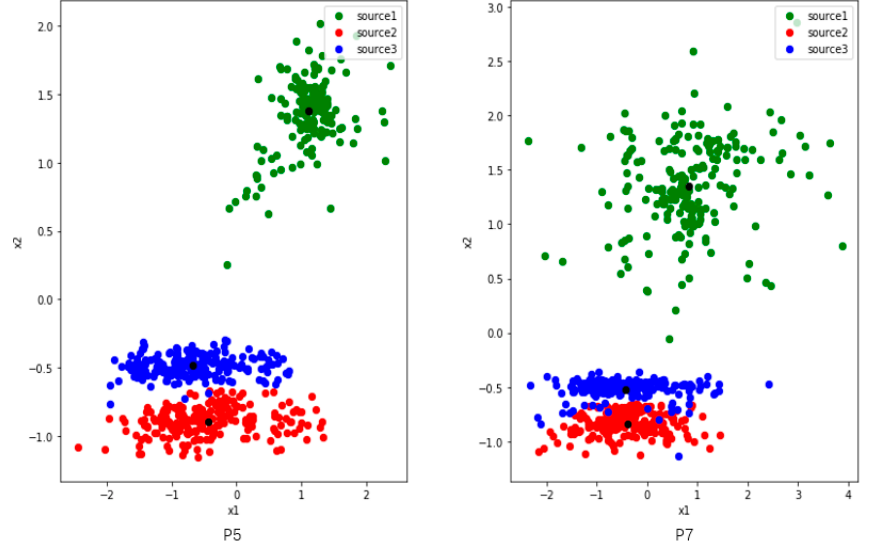
Figure 5. The distribution of three activities features which are collected from users P5 ( left ) and P7 ( right ) in UCI. The distributions of the two users are very similar. The red and blue points are close to each other, while the green one is dispersed and away from them. The black points are the centers of the three classes of features.